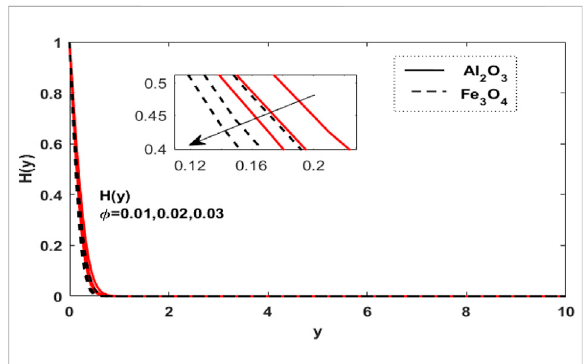
FIGURE 7 Variation of ϕ on H(y) when ∈ = 1, M = 1, and Pr = 29.86.